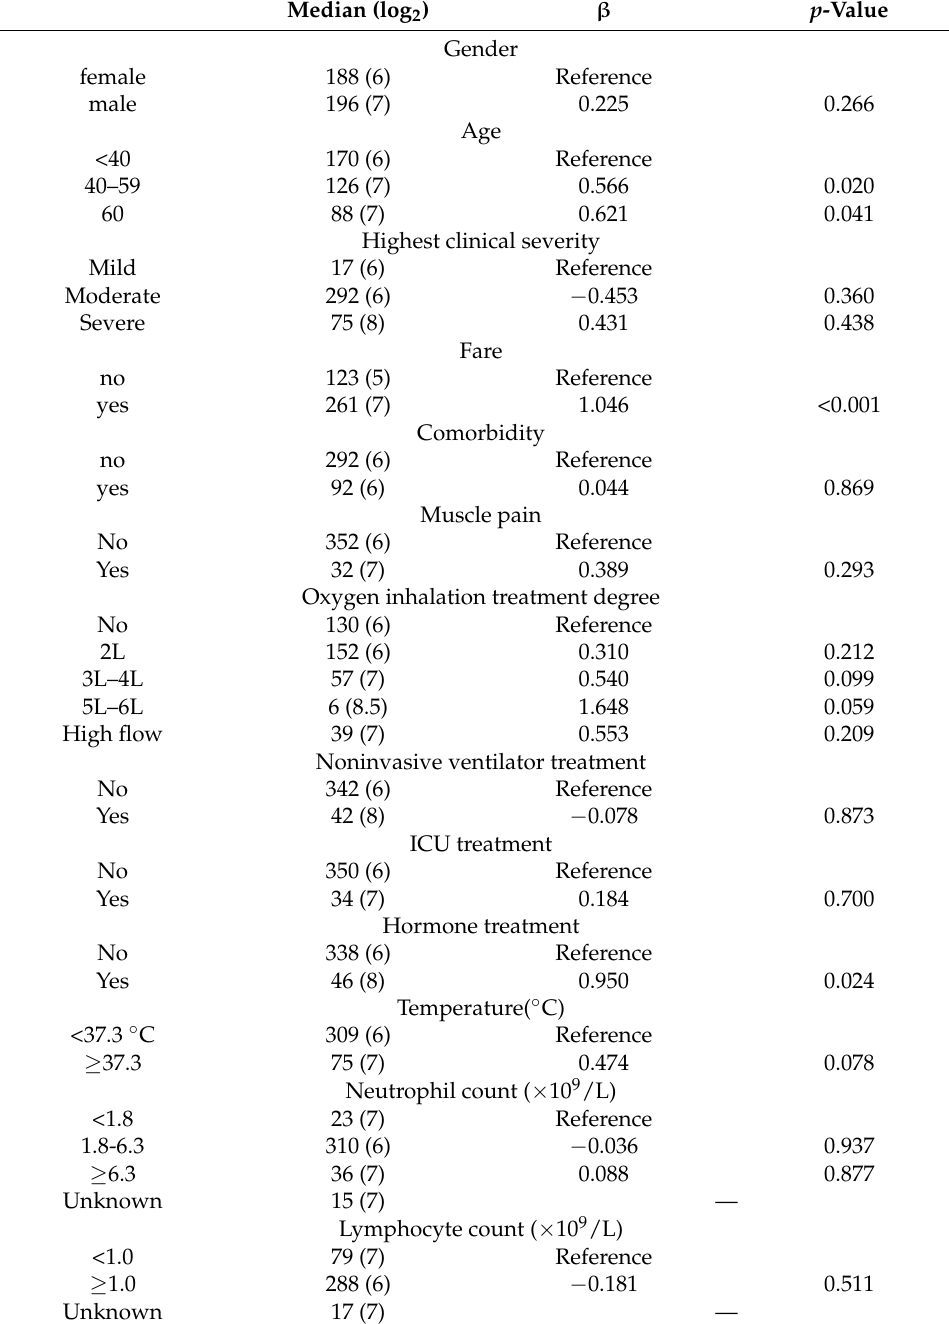
Table 2. Multivariate analysis of factors associated with NAb